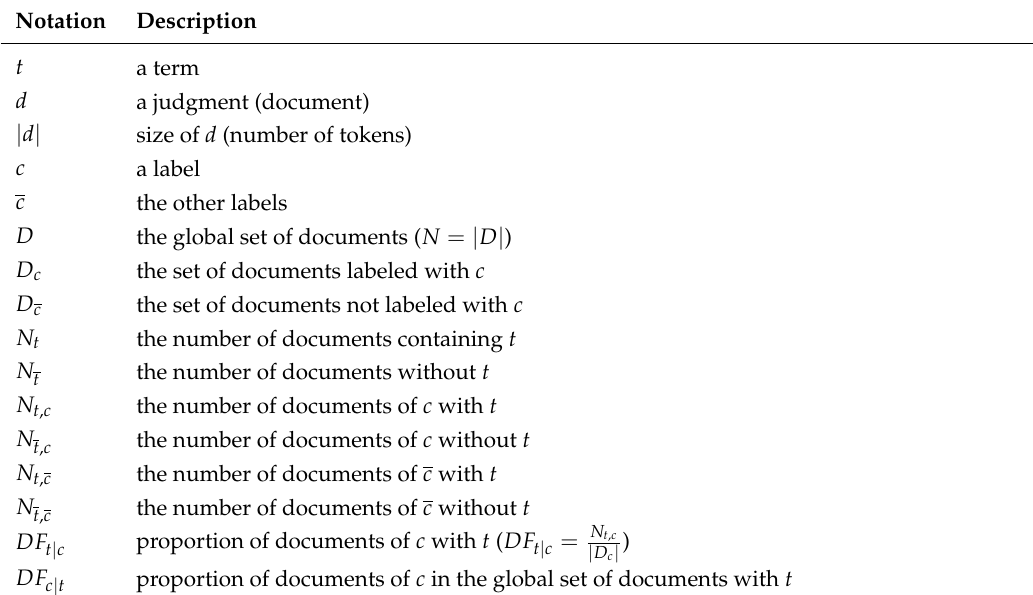
Table 4. Notation used in